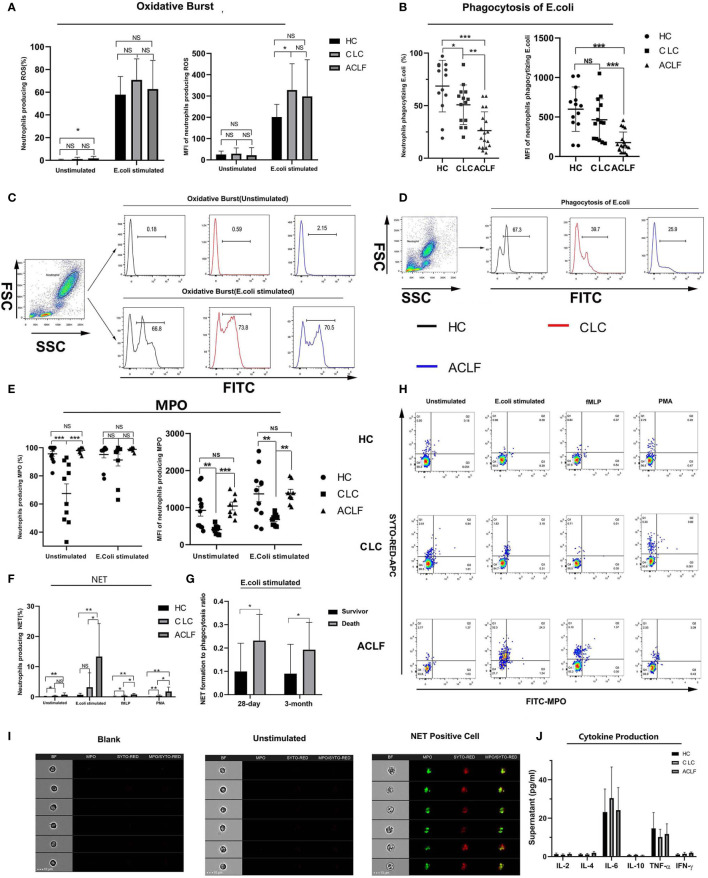
Multiple neutrophils functions in hepatitis B virus related acute-on-chronic liver failure (HBV-ACLF) patients. (A, C) The percentage and mean fluorescence intensity (MFI) of neutrophils producing reactive oxygen metabolites with or without E.coli stimulation in patients with HBV-ACLF (N=18), compensated liver cirrhosis (CLC) (N=14) or healthy control (HC) (N=13) and the representative graph showing the gating strategy, Data are expressed as mean ± standard deviation (SD). (B, D) The percentage and MFI of neutrophils phagocytizing E.coli in patients with HBV-ACLF (N=18), CLC (N=14), and HC (N=13) and the representative graph showing the gating strategy, Data are expressed as mean ± standard deviation (SD). (E) The percentage and MFI of neutrophils producing intracellular myeloperoxidase (MPO) in patients with HBV-ACLF (N=8), CLC (N=10), or HC (N=11). Data are expressed as mean ± standard error of mean (SEM). (F, H) The percentage of neutrophils producing NET in patients with HBV-ACLF (N=7), CLC (N=6), and HC (N=8) and the representative graph showing the gating strategy, Data are expressed as mean ± standard deviation (SD). (G) The ratio of percent of neutrophil extracellular trap (NET) producing neutrophils to that of phagocytic neutrophils in deceased ACLF patients or survivors at 28-day (deaths: four cases, survivors: 18 cases) or 3-month (deaths: six cases, survivors: 15cases). Data are expressed as mean ± standard deviation (SD). (I) Imaging flow of NET formation. The four columns showed the morphology, MPO fluorescence, SYTOX RED fluorescence and MPO-SYTOX RED merged fluorescence of single selected neutrophil. (J) Supernatant levels of IL-2, IL-4, IL-6, IL-10, TNF-α, and IFN-γ produced by neutrophils from patients with HBV-ACLF (N=7), CLC (N=5), and HC (N=6) after stimulated by lipopolysaccharide (LPS). Data are expressed as mean ± standard error of mean (SEM). Statistical analysis was performed by the Mann-Whitney u test. NS, P > 0.05; *0.01 ≤ P < 0.05; **0.001 ≤ P < 0.01; ***P < 0.001.